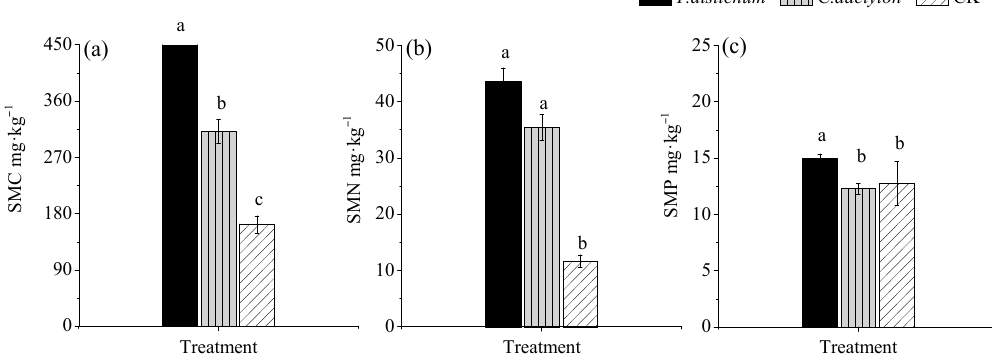
Figure 1. ( a ) Variations in SMC under different treatments, ( b ) Variations in SMN under different treatments, ( c ) Variations in SMP under different treatments CK: unplanted treatment, SMC: Soil microbial biomass C, SMN: Soil microbial biomass N; SMP: Soil microbial biomass P. Different lowercase letters represent significant differences ( p < 0.05) among different treatments.